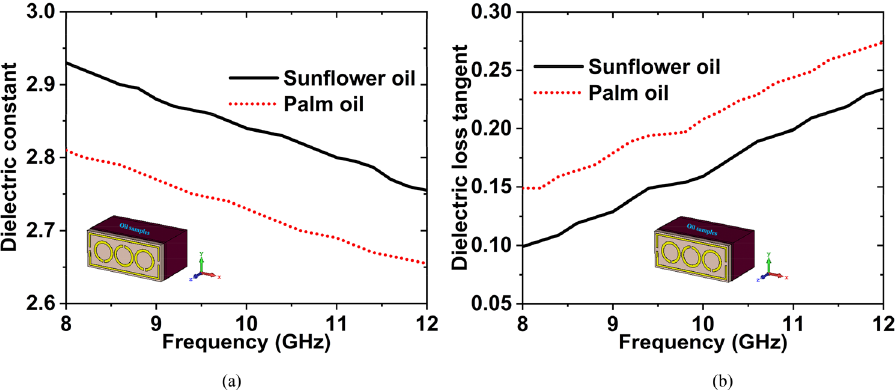
Figure 20. Experimental data of ( a ) DK ( b ) LT for the sunflower & palm oils.